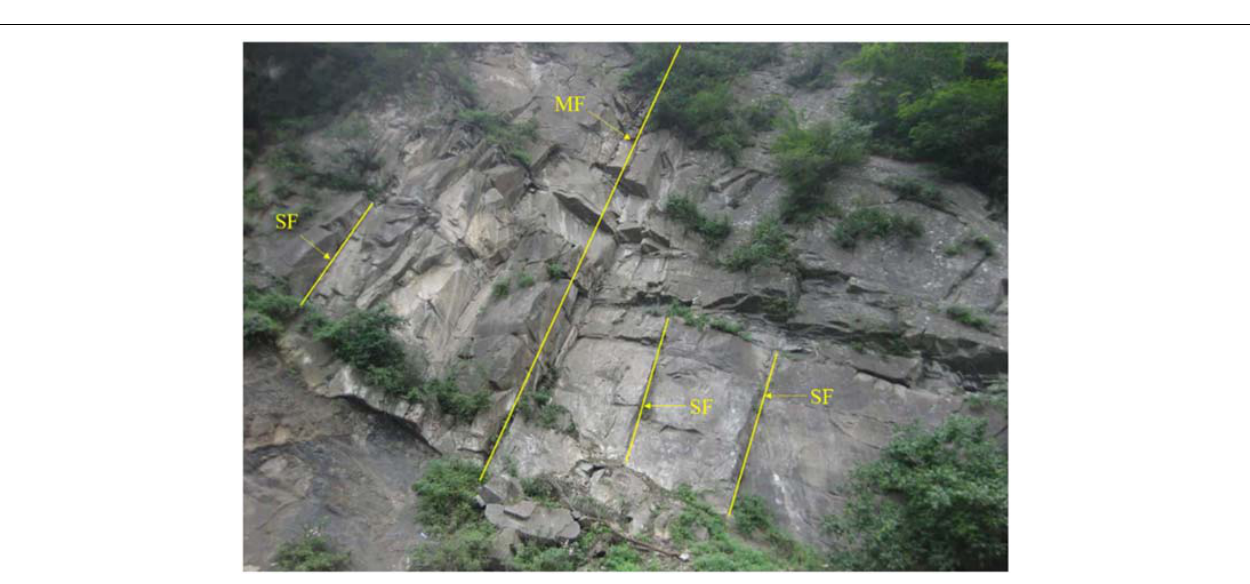
FIGURE 6 | Mesoscale and small-scale fractures in outcrops. MF refers to the mesoscale fracture; SF refers to the small-scale fracture.